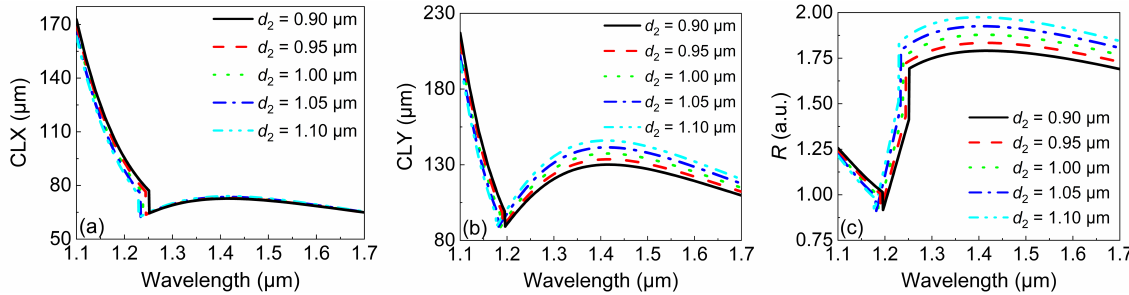
Figure 6. The variations in ( a ) the CLX and ( b ) CLY with the wavelength under different values of d 2 . ( c ) The variations in R with the wavelength under different values of d 2 .